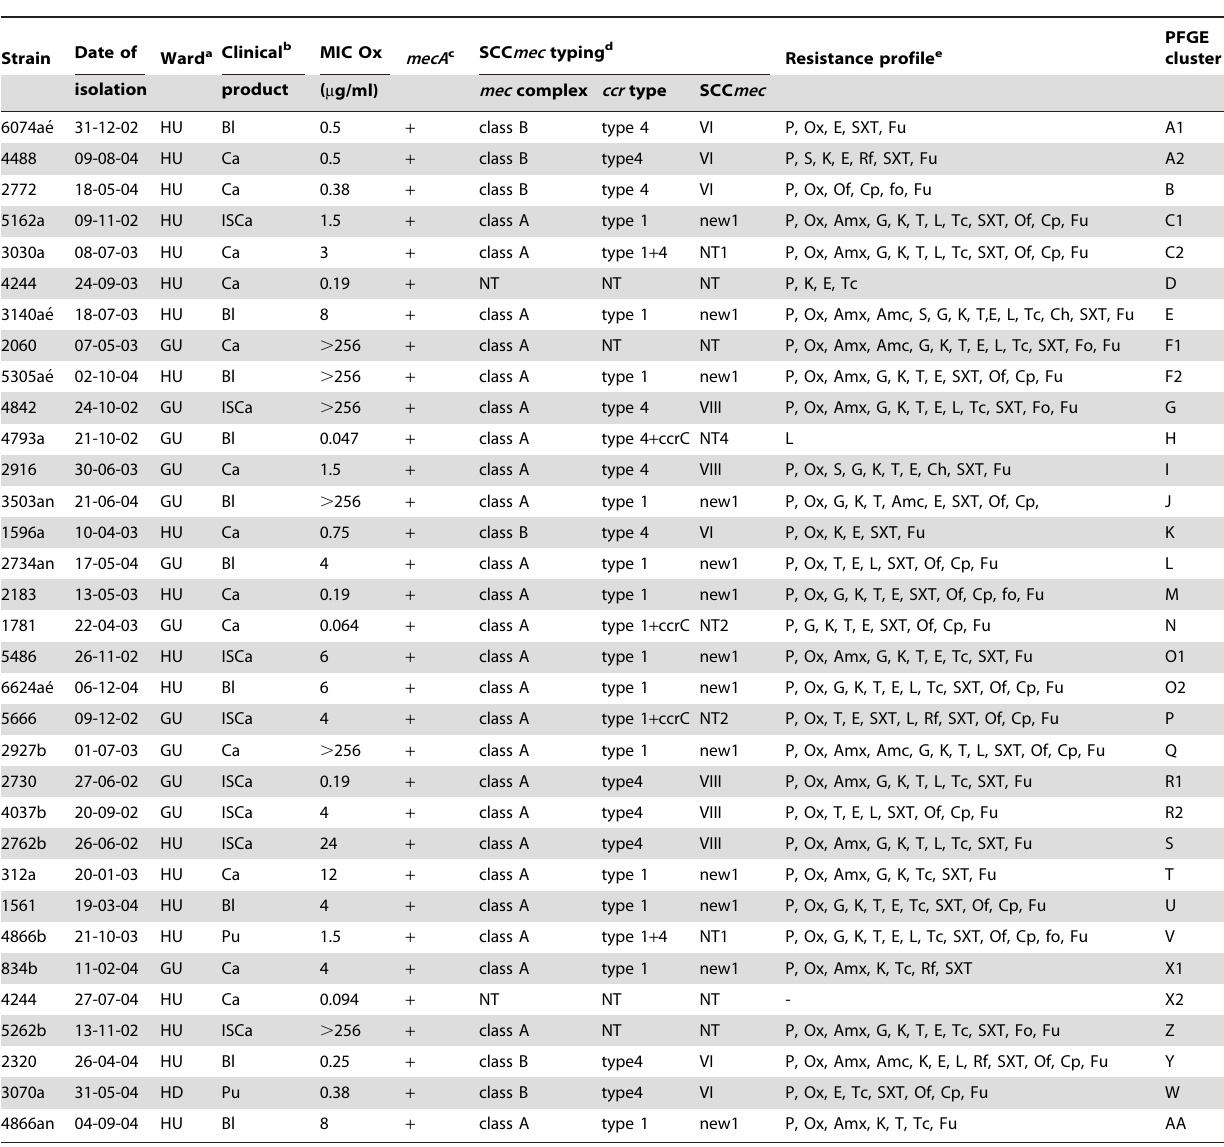
Table 1. Molecular and phenotypic characterization of methicillin-resistant S. hominis (MRSHo)